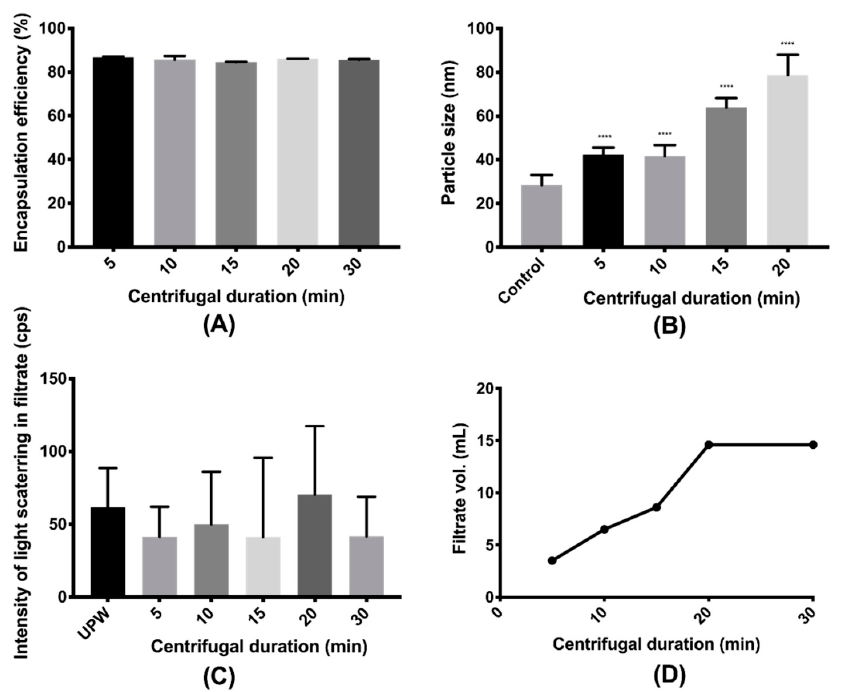
Figure 6. Effects of centrifugal duration on the ( A ) encapsulation efficiency and ( B ) particle size of the FLU nanoparticle as well as ( C ) intensity of light scattering in filtrate and ( D ) volume of the filtrate at speed of 4000 × g (**** denotes 0.0001 ≥ p comparing with control).